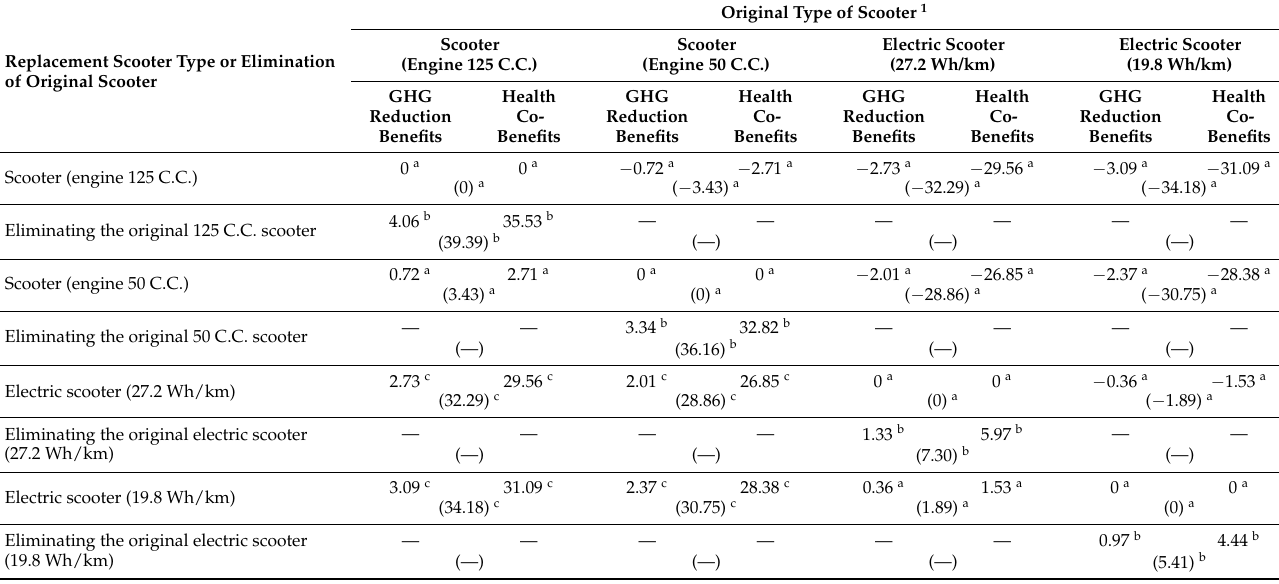
Table 10. Benefit matrix of GHG emission reduction and corresponding health co-benefits from changing scooter types.